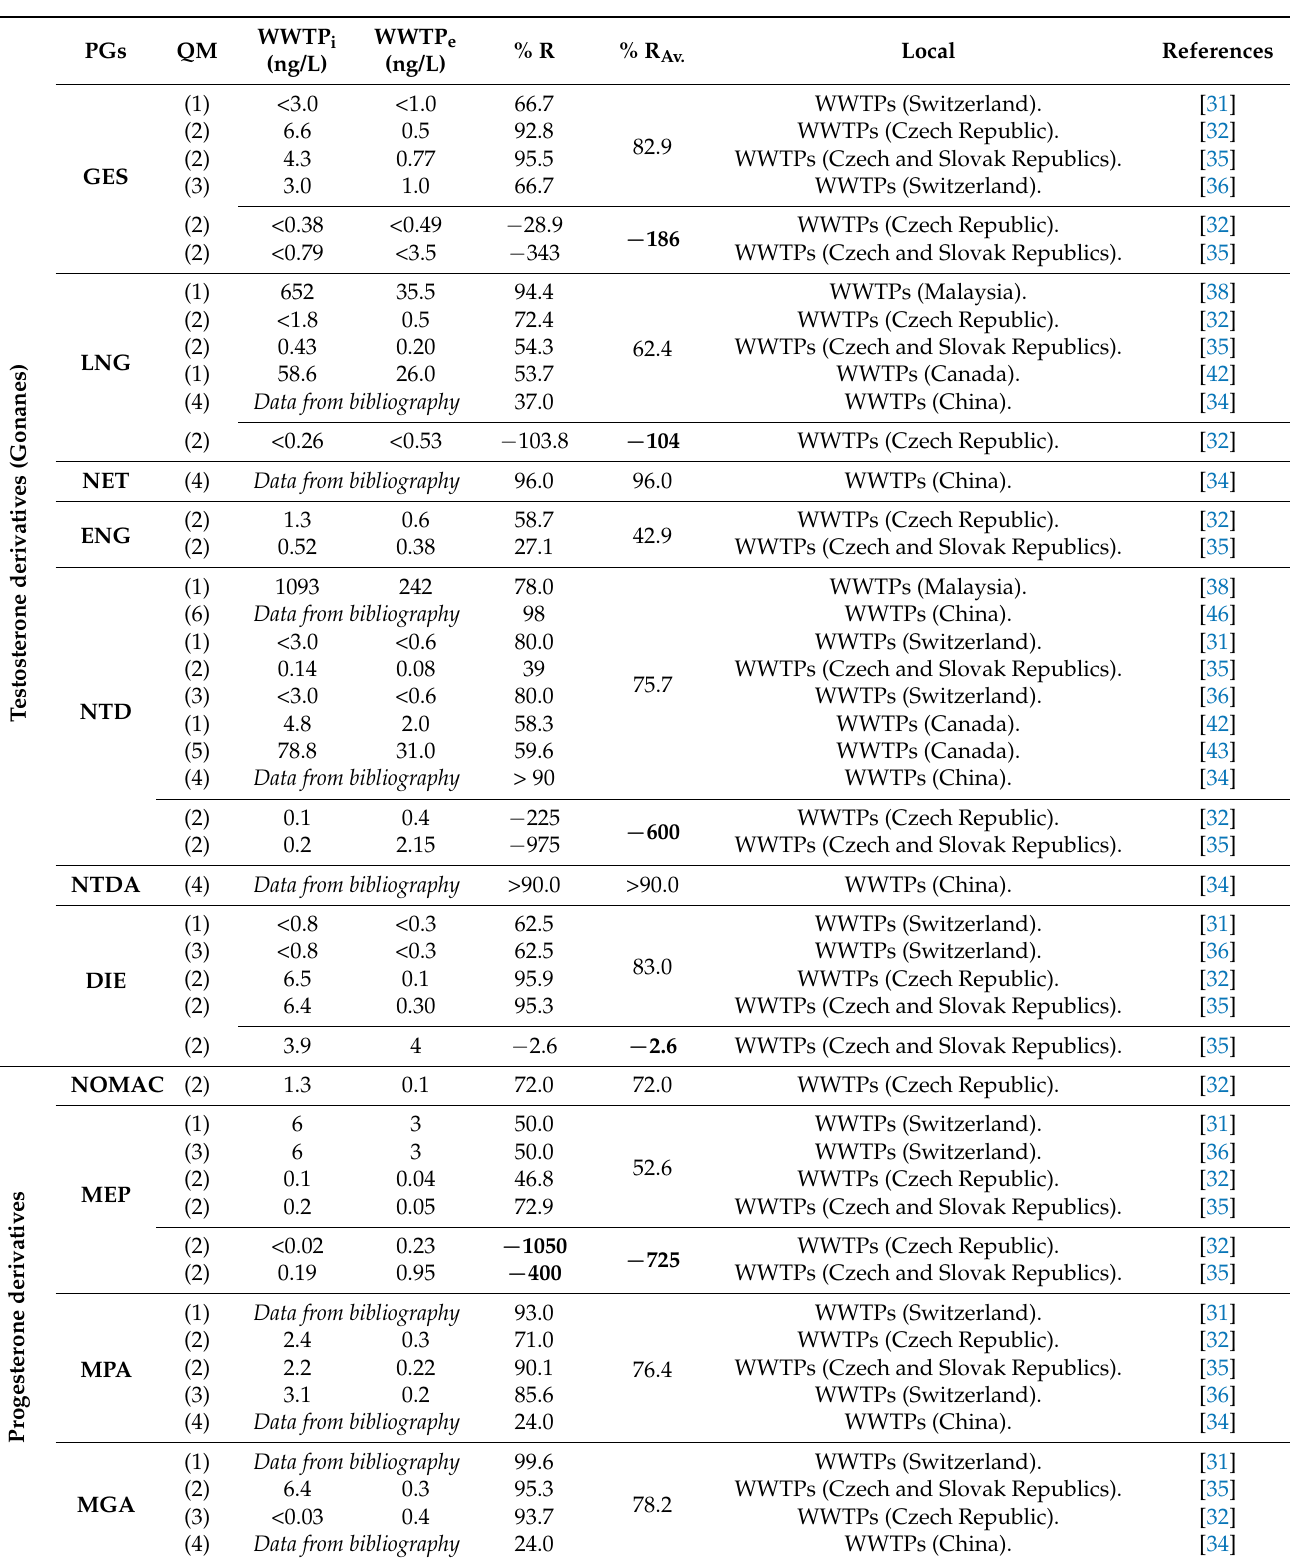
Table 3. Worldwide WWTPs removal efficiency of PGs. In bold are shown the situations when the treated effluent contains higher amounts of a certain PG than its influent (these values were set apart from the global average percentage of removal, % R Av. ). Quantification method (QM);